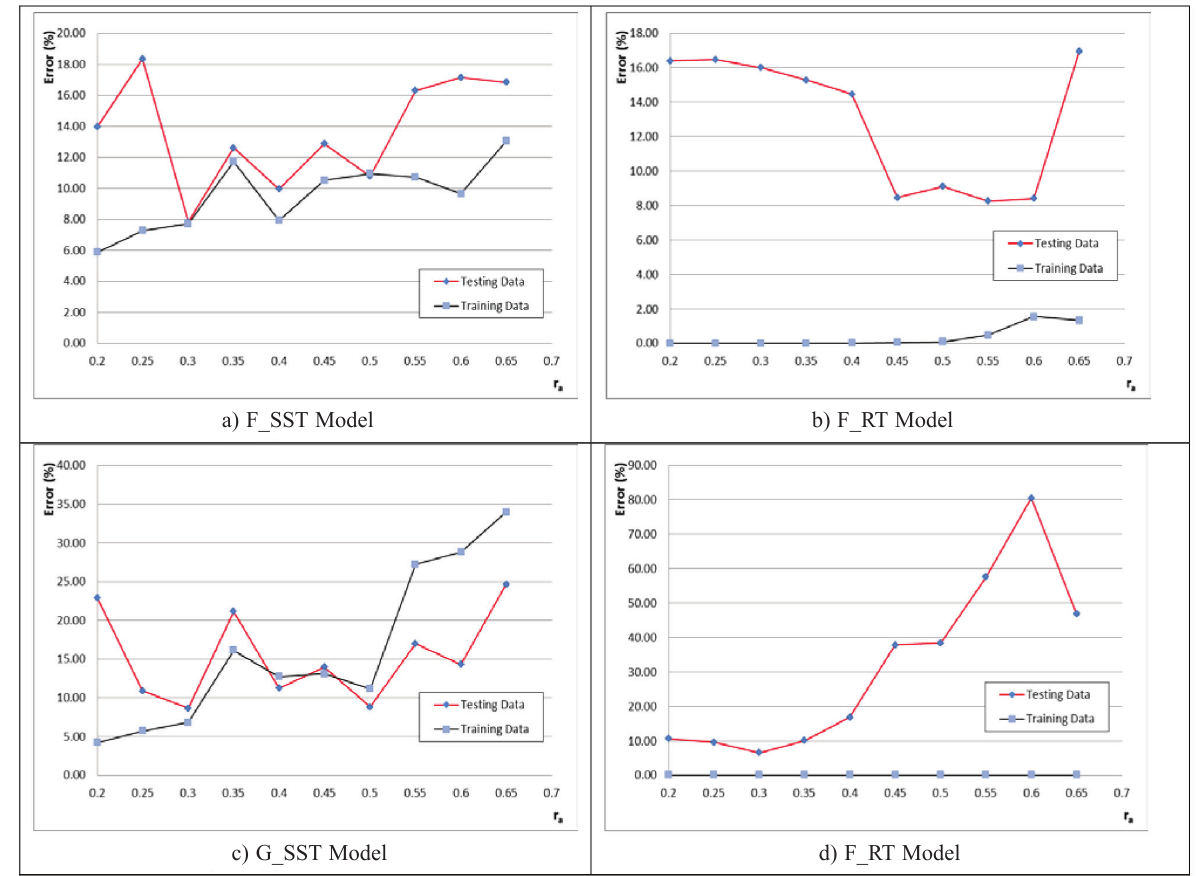
Fig. 4. Models’ mean absolute percentage error